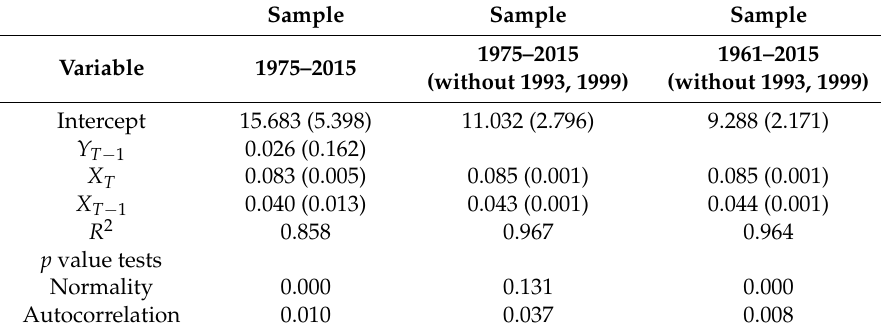
Table 3. Estimation results for various regression models relating inflation with lagged inflation and current and lagged percentage changes in stamps prices. Estimated Newey-West adjusted standard errors are in